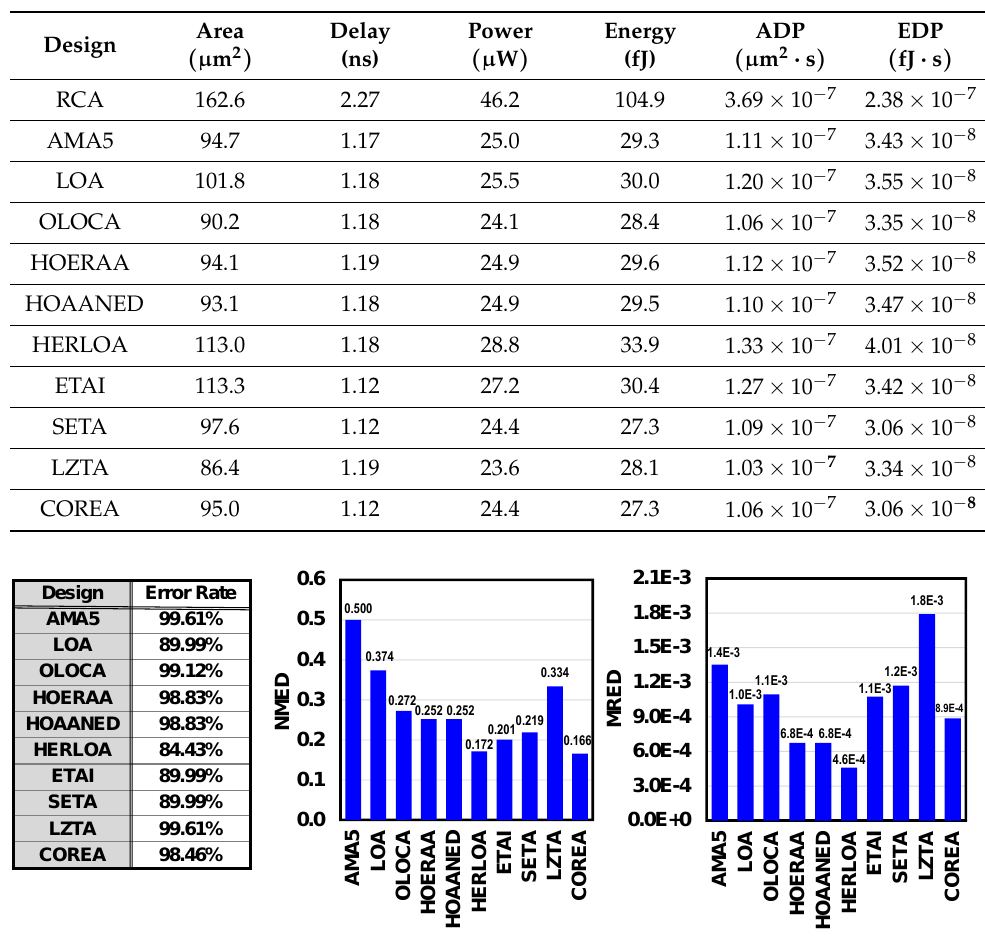
Table 1. Hardware performance summary of various 16-bit adders.